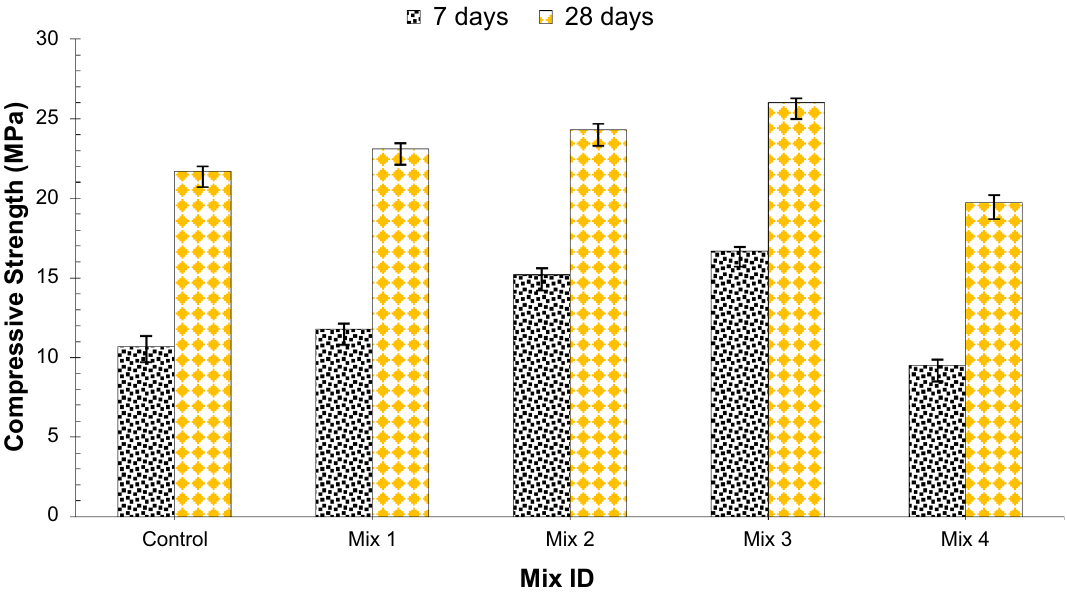
Figure 3. Compressive strength of concrete at 7 and 28 days of